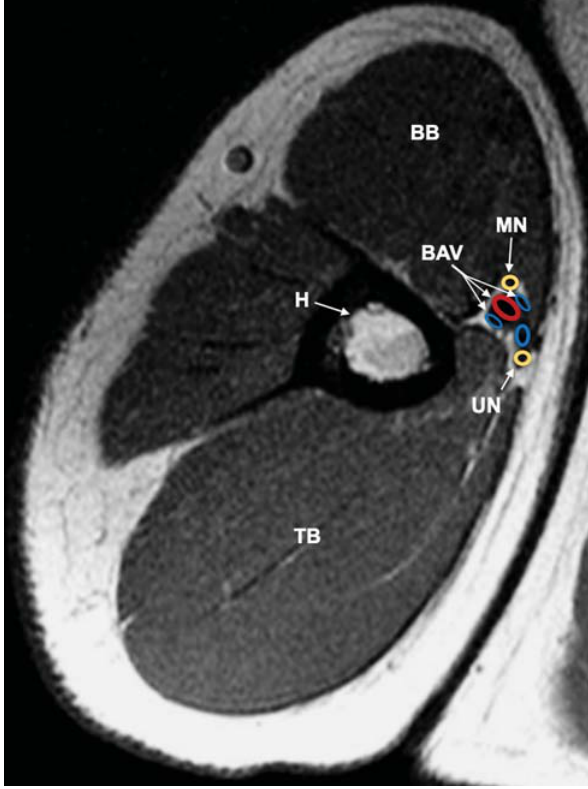
Fig. 2 MRI ( axial view ) of the upper extremity illustrating structures withinthe MBFC. BAV, brachial arteryand veins; BB, bicepsbrachii; BV, basilica vein; H, humerus; MN, median nerve; MBFC, medial brachial fascial compartment; MRI, magnetic resonance imaging; TB, triceps brachii; UN, ulnar nerve.